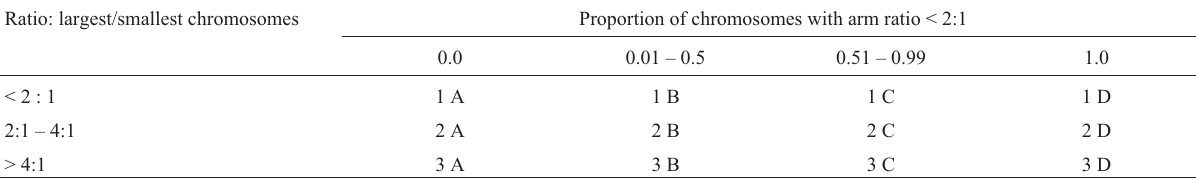
Table 1 - Intrachromosomal asymmetry indexes. The total of 12 indexes is composted of the four categories of Stebbin s (1971) - A to D according to the proportion of acrocentric and/or telocentric chromosomes in a karyotype - and subtypes 1 to 3 according to the ratio between the large/small chromosome arms in each of